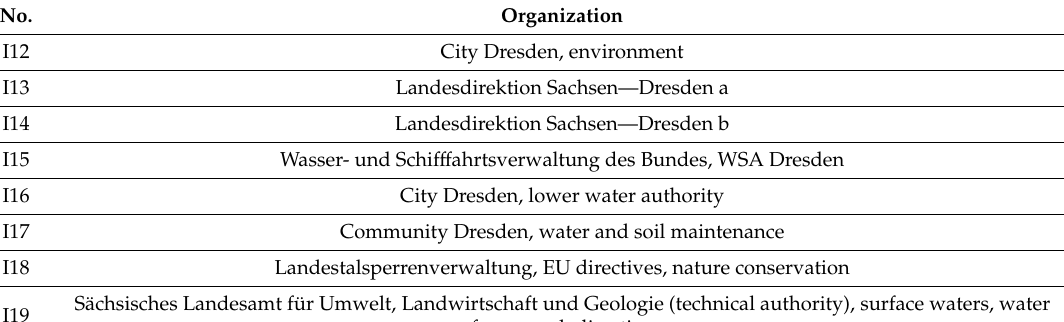
Table A2. Saxony: January / April / May 2017, December 2018, January 2019.